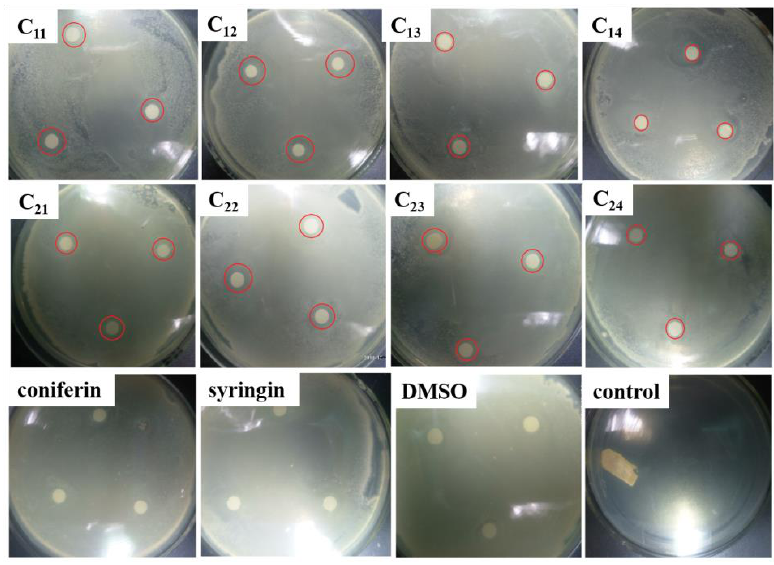
Figure 3. Effect of DHP fractions on growth inhibition of E. coli. Legend: The red circle area is the inhibition zone; coniferin and syringin: precursors of DHP; DMSO: No sample was added, only DMSO was added; control: control group without sample and solvent.